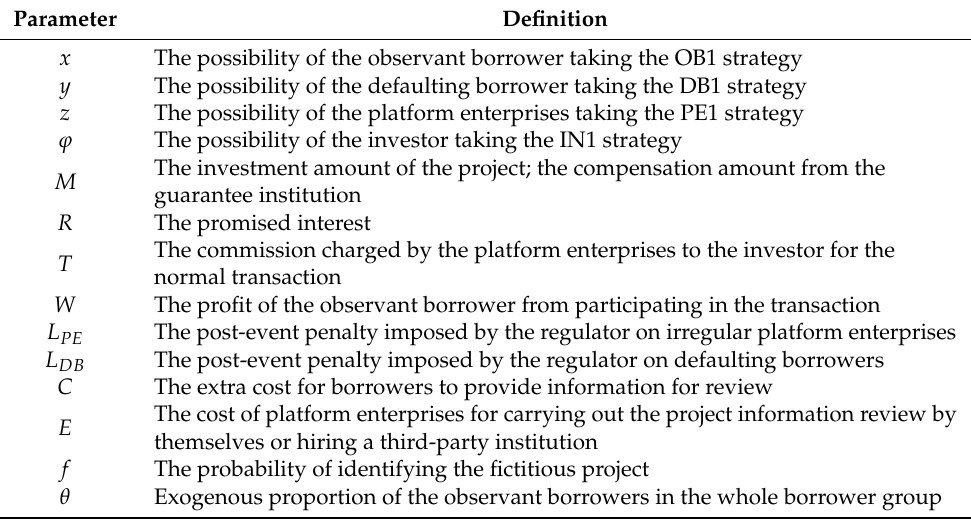
Table 1. Definitions of the parameters related to different game strategies.